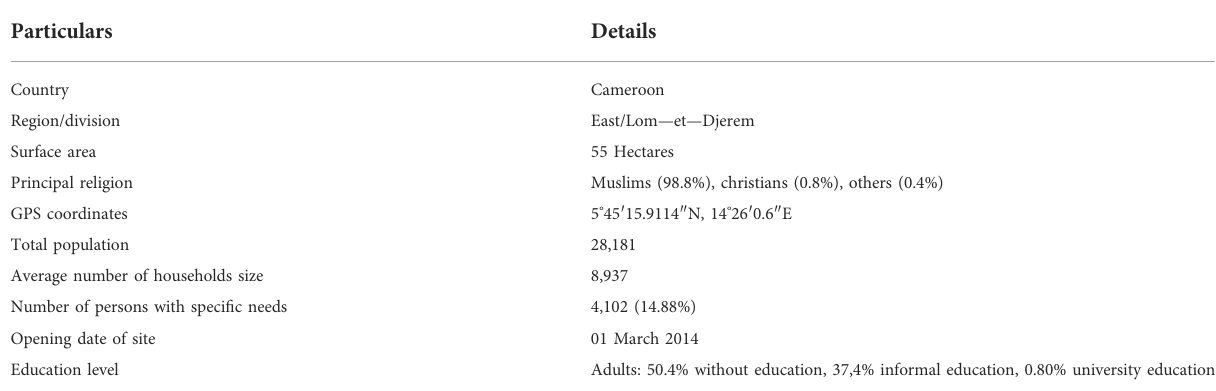
TABLE 2 Summarized information about the study